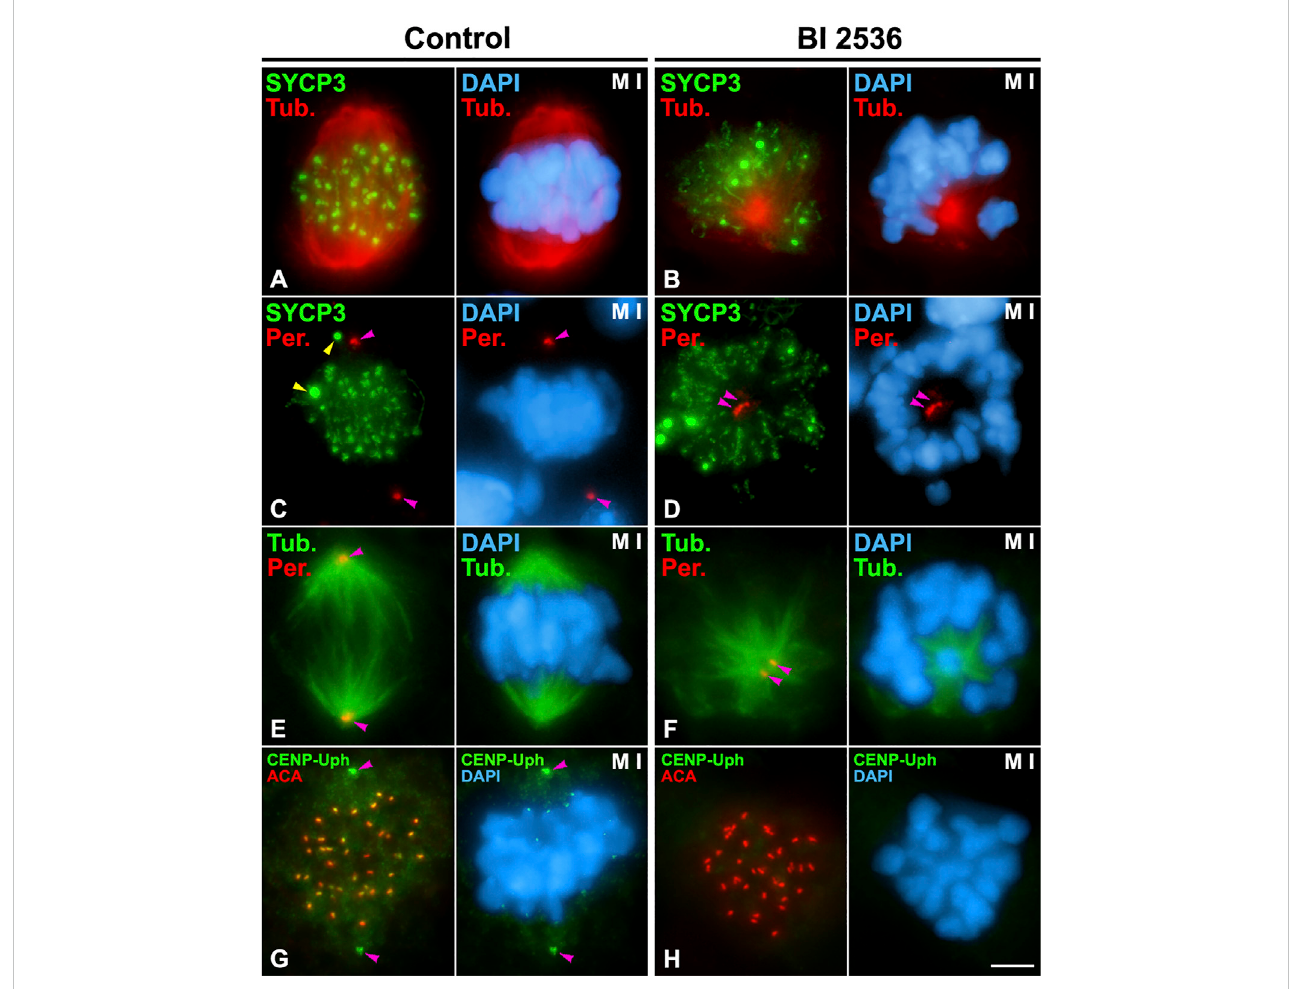
FIGURE 3 Ef fi ciencyofBI2536onculturedseminiferoustubules.DoubleimmunolabelingsofSYCP3(green)and α -Tubulin(red) (A,B) ;SYCP3(green)andPericentrin(red) (C,D) ; α -Tubulin (green) and Pericentrin (red) (E,F) ; or CENP-Uph (phosphorylated at T78) (green) and kinetochores (ACA, red) (G,H) , and counterstaining of the chromatin with DAPI (blue) on squashed control (A,C,E,G) and 8 h BI 2536-treated (B,D,F,H) metaphase I spermatocytes. Yellow arrowheads indicate SYCP3 agglomerates in the cytoplasm of a control metaphase I spermatocyte (C) . Pink arrowheads indicate the centrosomes (C,D,E,F,G) . Scale bar represents 5 μ